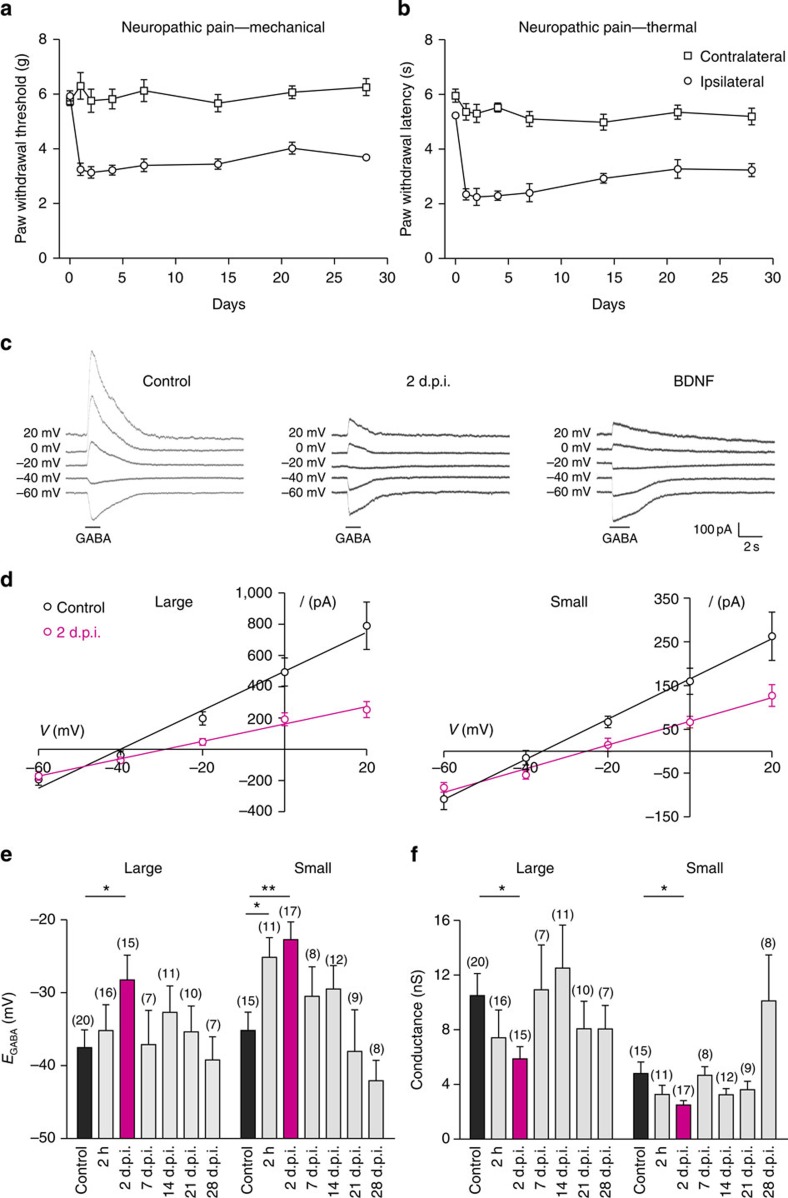
CCI induced a transient depolarizing shift of EGABA and reduction of GGABA in primary sensory neurons.Mechanical (a) and thermal hyperalgesia (b) induced by CCI surgery on the left sciatic nerve. n=7 mice (two-way analysis of variance; P<0.0001 for both). (c) Representative traces of GABA-activated currents recorded in DRG neurons during gramicidin perforated patch at various holding potential mV. (d) Current–voltage relationship for GABA-activated response from large (left) and small (right) neurons. (e) Bar graph showing the time course of the changes in EGABA. (f) Bar graph showing the time course of the changes in conductance of GABAAR. The number of neurons recorded is indicated in parentheses in each panel. *P<0.05; **P<0.01; unpaired t-test. Error bars indicate s.e.m.